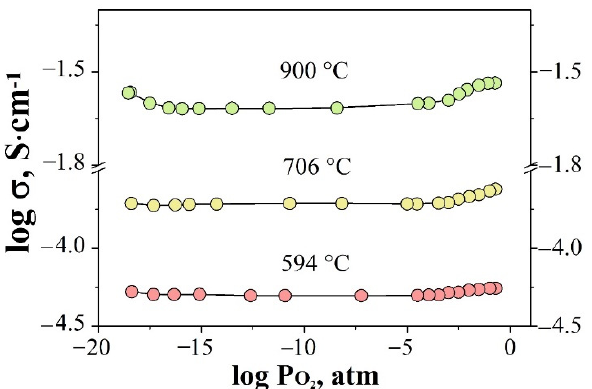
Figure 8. Oxygen partial pressure dependencies of conductivity for the sample Gd 1.95 Mg 0.05 Zr 2 O 6.97 at different temperatures .